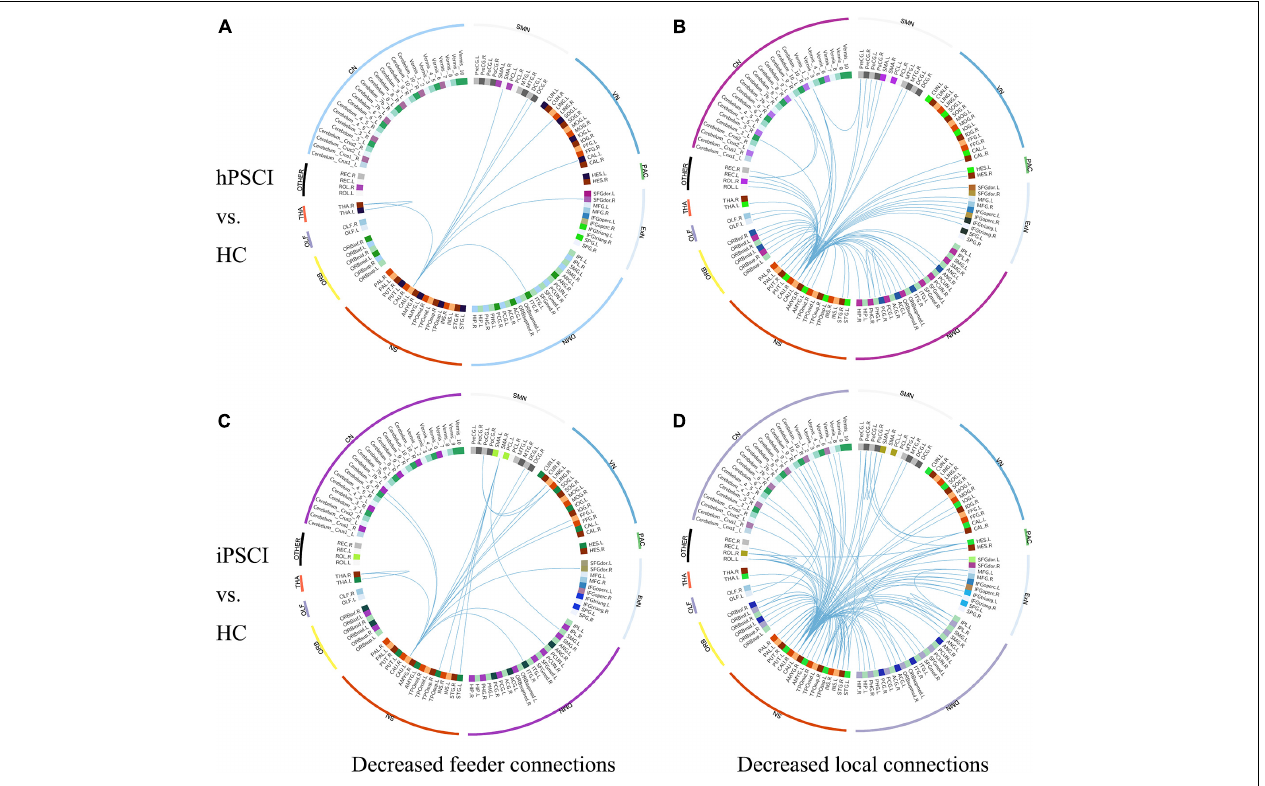
FIGURE 2 | The decrease in functional connectivity in PSCI relative to HC. (A) Decreased feeder connections in hPSCI versus HC. (B) Decreased local connections in hPSCI versus HC. (C) Decreased feeder connections in iPSCI versus HC. (D) Decreased local connections in iPSCI versus HC. HC, healthy controls; hPSCI, hemorrhagic post-stroke cognitive impairment; iPSCI, infarct post-stroke cognitive impairment; ORB, orbitofrontal cortex; SN, salience network; DMN, default-mode network; ExN, external frontoparietal network; PAC, primary auditory cortex; VN, visual network; SMN, sensorimotor network; CN, cerebellum network; THA, thalamus; OLF, Olfactory